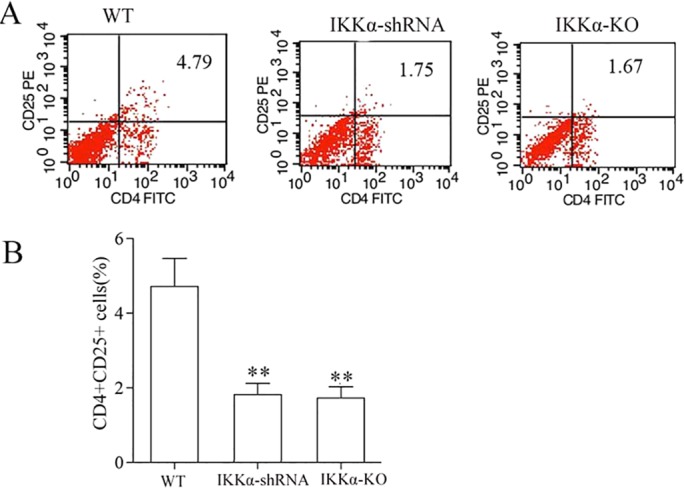
Percentage of kidney-infiltrating Treg cells after renal IR. Total kidney cells were gated on the CD4+ and CD25+ population before the analysis shown. (A) The percentage of CD4+CD25+ Treg cells was decreased in IKKα-shRNA or IKKα-KO (IKKαfl/fl, Cre+/−) kidneys compared with wild type after 3 days, as assessed by flow cytometry analysis. (B) The percentage of CD4+CD25+ Treg cells in kidneys was determined. Data are presented as mean±s.d. (n=6 mice). **P<0.01 versus wild type.